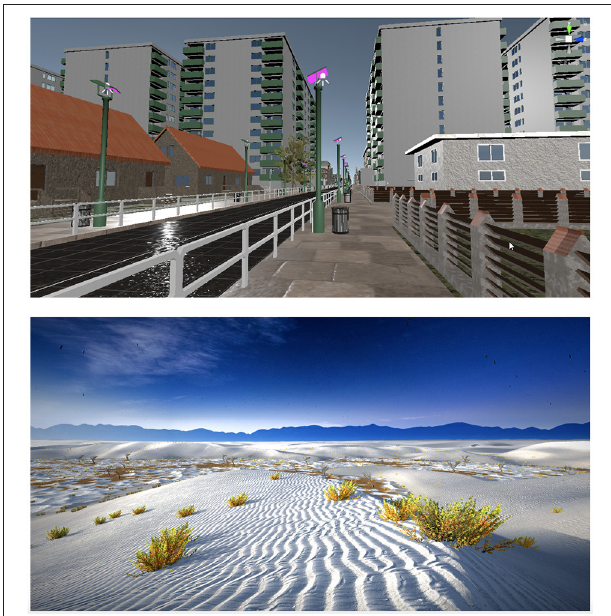
FIGURE 2 | The virtual exposure environment must provide the patient with a sufficient level of realism for the VRET to be effective. The photos show examples of high-quality computer graphics of opened space exposure environment from the VR voice-BOT application, developed (photos made by MK). Before treatment, the patient determines the type of phobic environment, as well as customizes it depending on his preferences, specifying the time of day, weather and the type of exposure. Exposure in a three-dimensional graphics environment is enriched with three-dimensional sound, recorded in real conditions. Next, VR voice-BOT, thanks to the speech recognition system, conducts an exposure hierarchy with the patient, increasing the intensity of phobic stimuli in the environment previously defined by the patient and asking him to determine the subjective level of distress in the subjective units of distress scale (SUDS). During the exposure, the patient uses his own smartphone with the application installed on it, and a joystick, and moves freely in a virtual